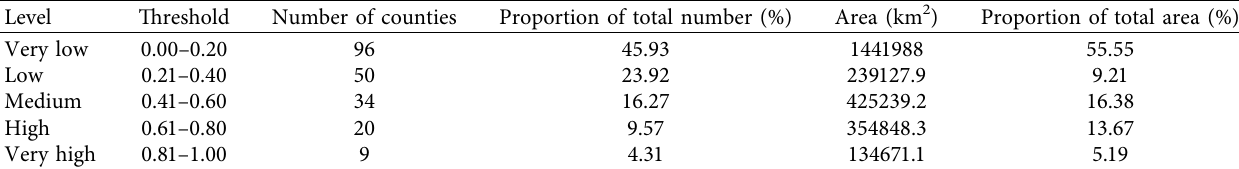
Table 2: Statistics of transportation infrastructure influence degree ( TIID ) in Qinghai-Tibet